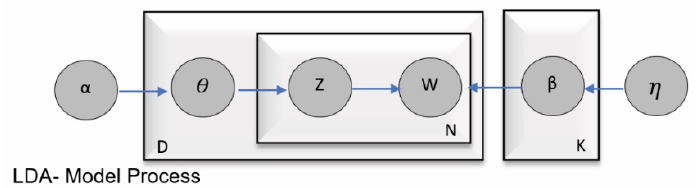
Figure 2. Probabilistic generative process LDA.